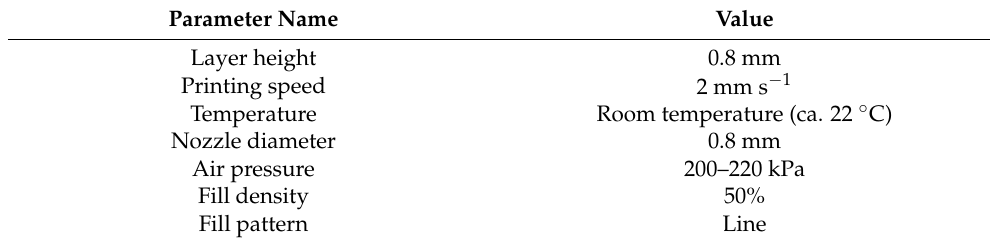
Table 1. Parameters for printing